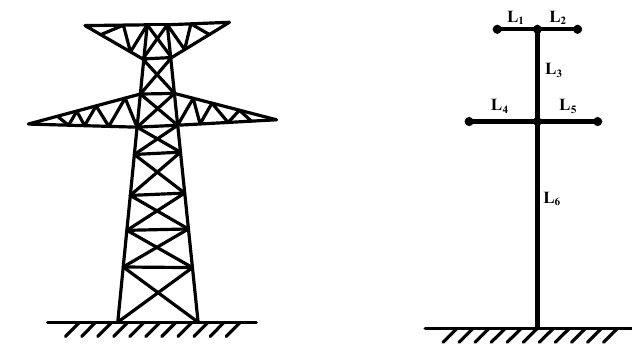
Figure 3. Tower on the DC pole and the equivalent model of the tower.